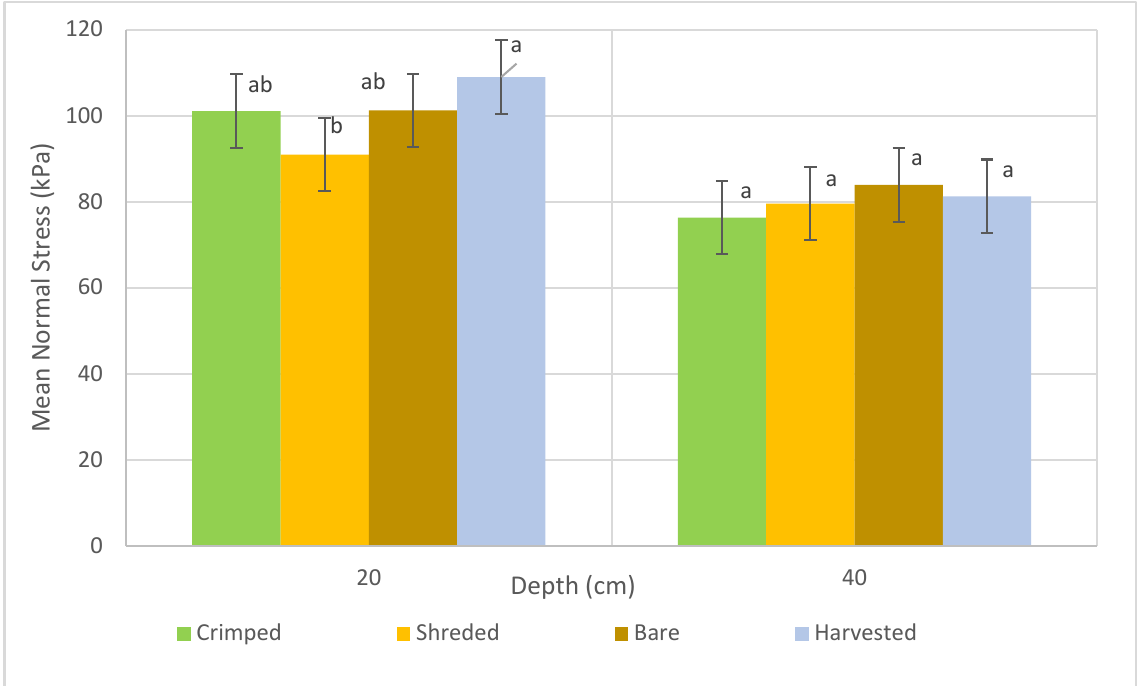
Figure 8. Results of the statistical analysis of mean normal stress (kPa). Residual standard errors were used on the bar error. Treatments with the same letter are not significantly different.